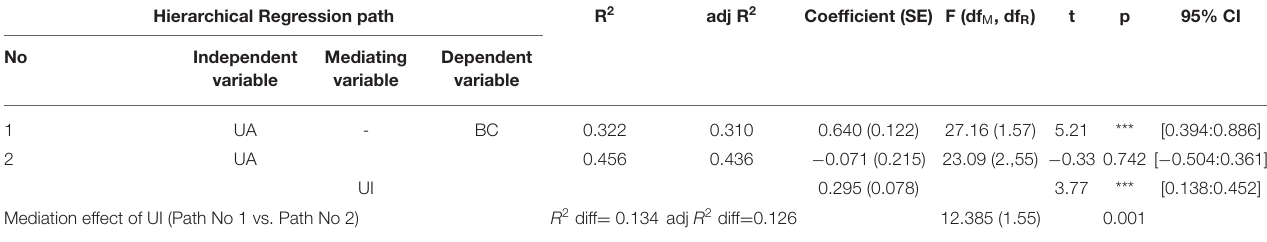
TABLE 2 | Hierarchical regression results for examining the mediation role of UA, UI in BC prediction in the adopted mTAM model ( Figures 2 , 3 ). Hierarchical Regression